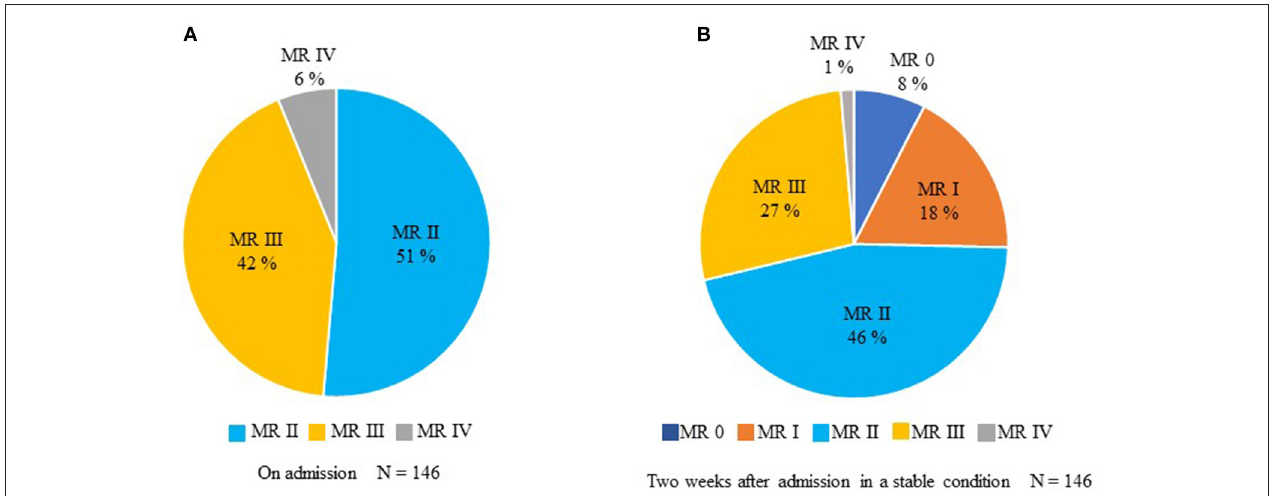
FIGURE 2 | The temporal change in MR from admission to 2 weeks after entry in a stable condition. (A) Assessment of MR on admission. (B) Evaluation of MR 2 weeks after